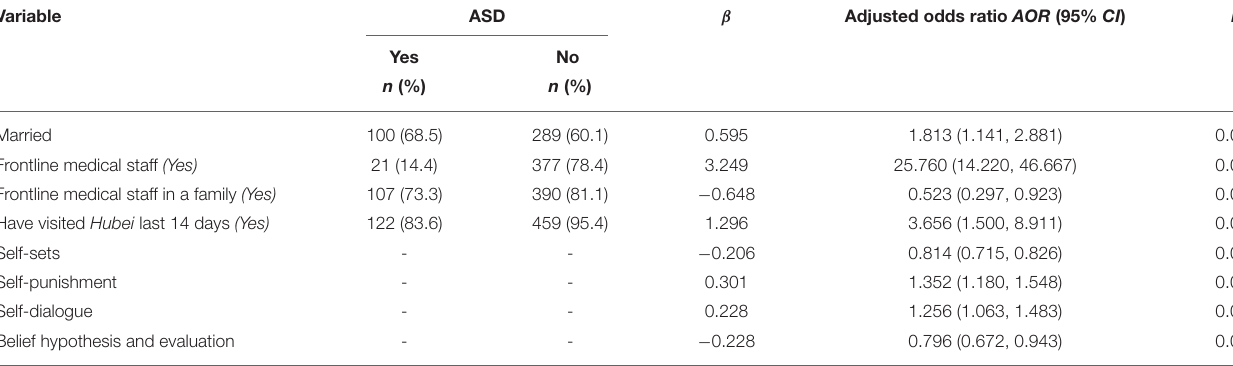
TABLE 5 | Binary logistics regression analysis of influencing factors of ASD in medics ( n = 627).